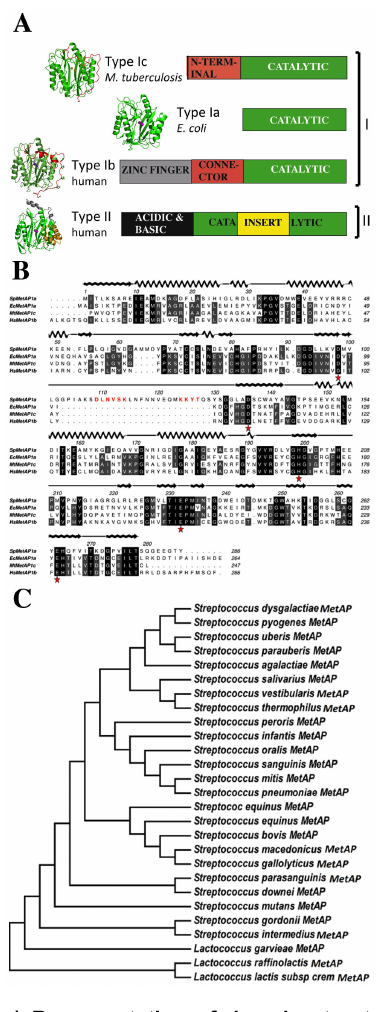
Figure 1. a) Representation of domain structure of sub- classes of MetAP based on the crystal structures. Common catalytic regions are shown in green. Type Ia has the basic structure required for catalysis. Type Ib and Type Ic have extra regions on the amino terminus. Type II MetAP has a 60 amino acid insert in addition to N-terminal extension (yellow). On the left of each bar is the representative crystal structure in cartoon diagram. Pink spheres in the middle indicate the two metal ions in the active site. b) Sequence alignment of Type I MetAPs from S. pneumoniae (Type Ia), E. coli (Type Ia), M. tuberculosis (Type Ic) and human (Type Ib). Numbering and the secondary structure representation on the top of the alignment are based on the Sp MetAP1a crystal structure. Metal binding conserved residues are marked as asterisk. Two inserts are identified 63 ; insert and 103 insert. These inserts are predominantly present in the streptococcus bacterial Type Ia MetAP 109 . DLNVSK and 124 KKYT are two sequences marked in red are predicted to have respectively glycosylation and phosphorylation sites. c) Phylogenetic tree of 24 Type I MetAPs from streptococcal and lactococcal bacteria that contain the two inserts observed in the Figure 1b. Note that each of these species forms separate